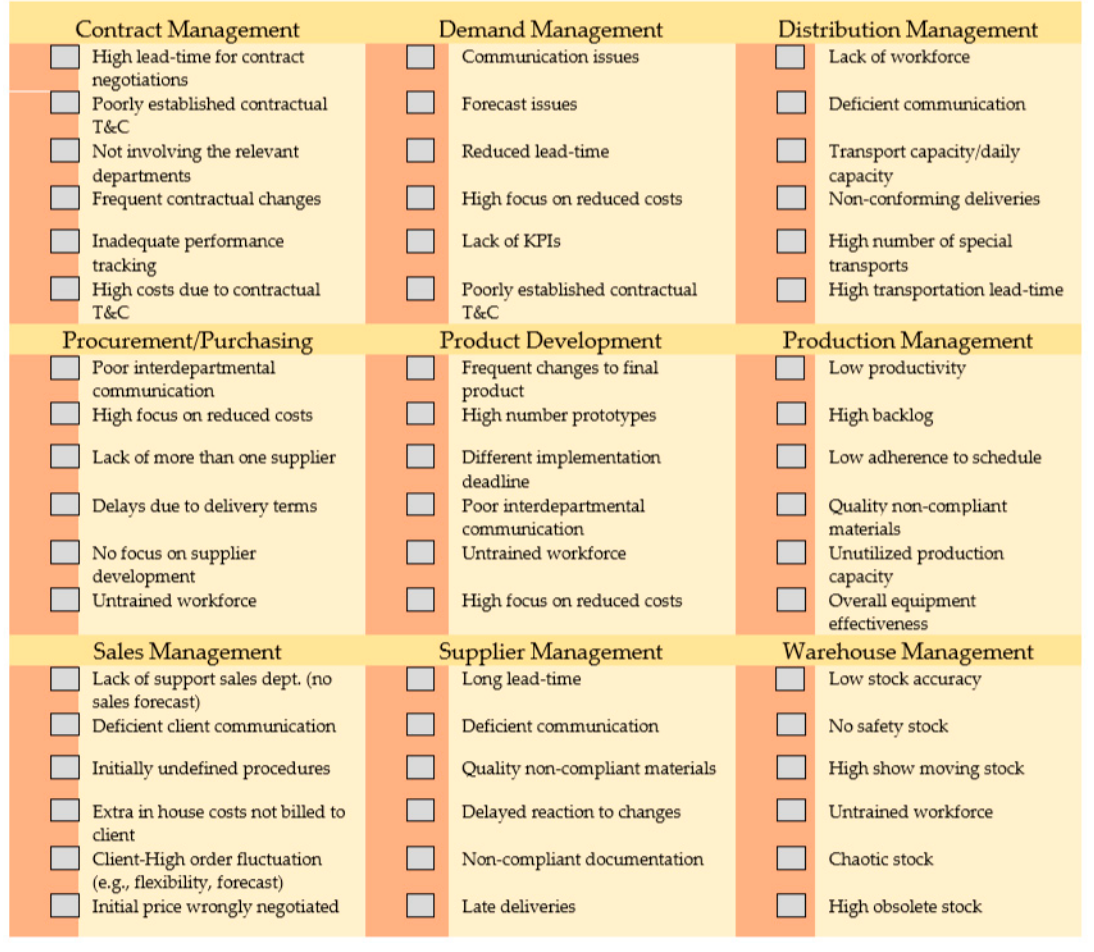
Figure 2. Graphical user interface generated by the Python script.